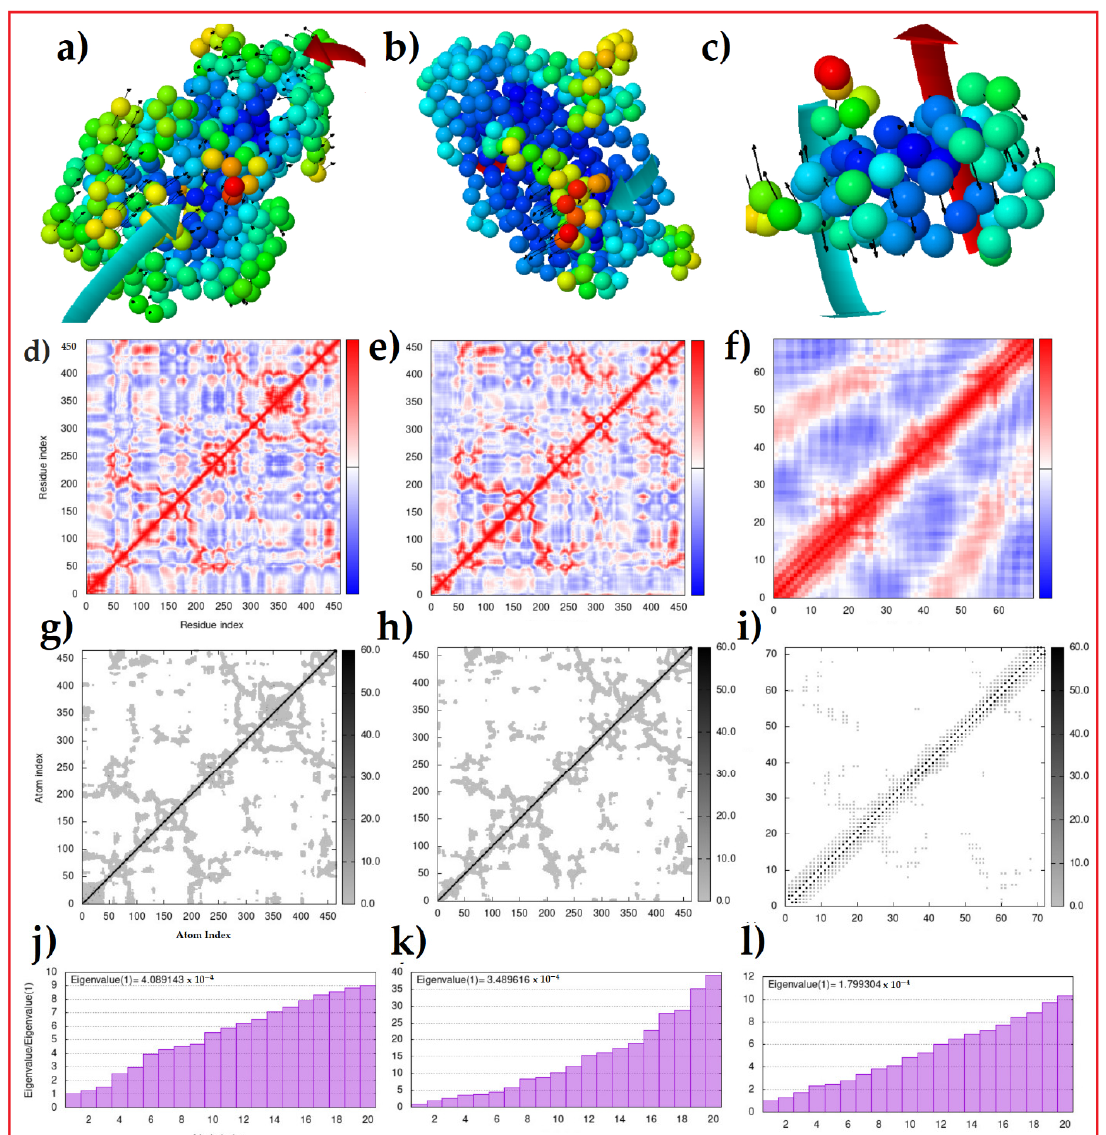
Figure 2. ( a – c ) The complexes of wild-type, mutant Glu336Lys and Arg70* variants with substrate L2HG. ( d – f ) The covariance matrixes of wild-type, mutant Glu336Lys and Arg70* variants with substrate L2HG. ( g – i ) The results of the elastic network models of wild-type, mutant Glu336Lys and Arg70* variants with substrate L2HG. ( j – l ) The eigenvalues of wild-type, mutant Glu336Lys and Arg70* variants with substrate